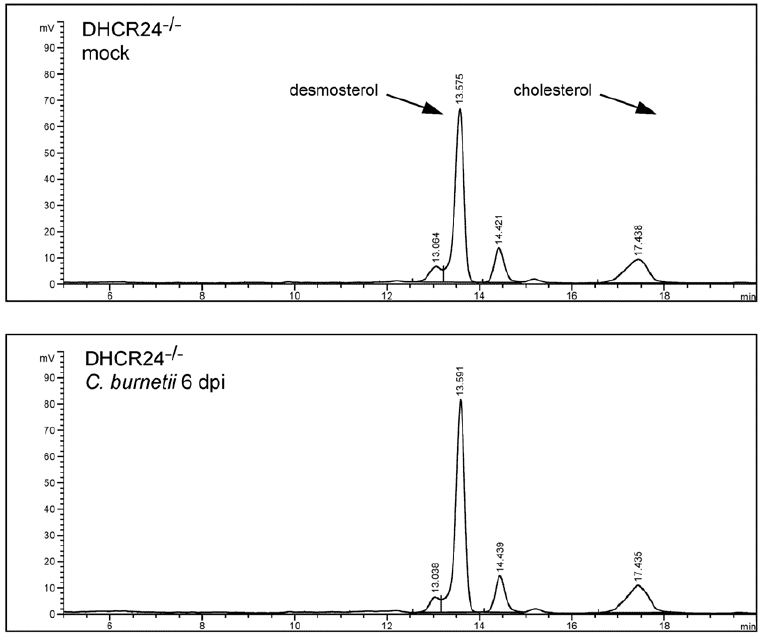
Figure 7. C.burnetii does not generate cholesterol in host cells. HPLC analysis of C. burnetii - and mock-infected 2 cholesterol MEFs at 6 dpi. Despite expressing a functional sterol reductase [59], there is no detectable cholesterol in infected cells, indicating C. burnetii does not generate cholesterol from host cell sterols.